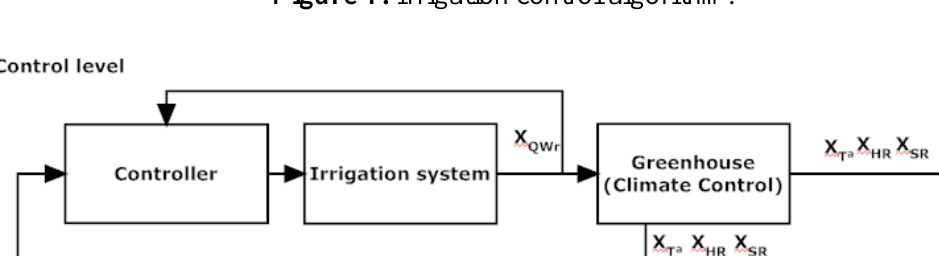
Figure 1. Irrigation control